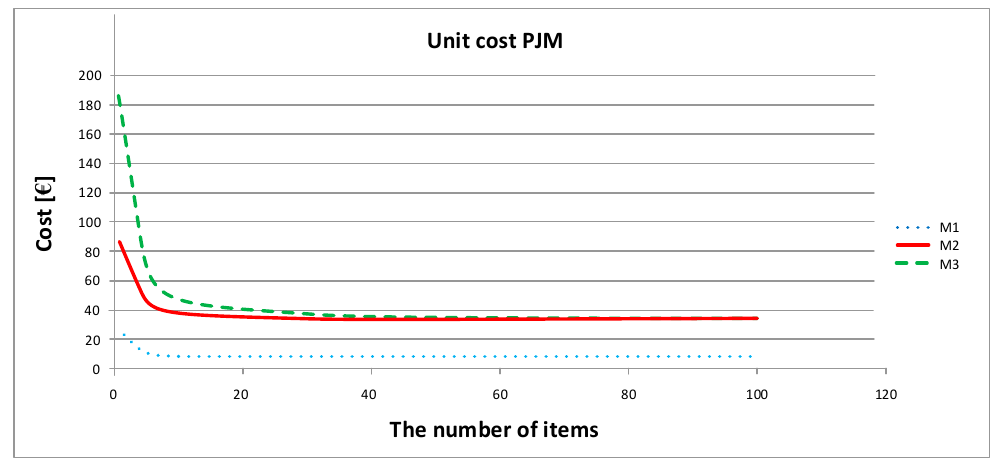
Figure 11. Dependence of the rotor production costs on the number of prototypes for SLS technology.